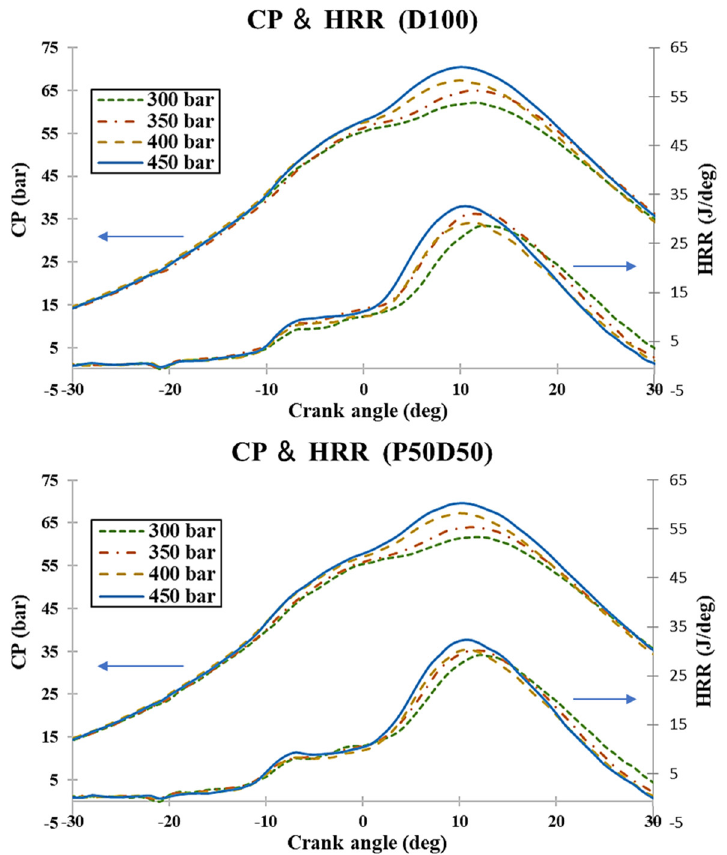
Figure 2. CP and HRR variations under various injection pressures.